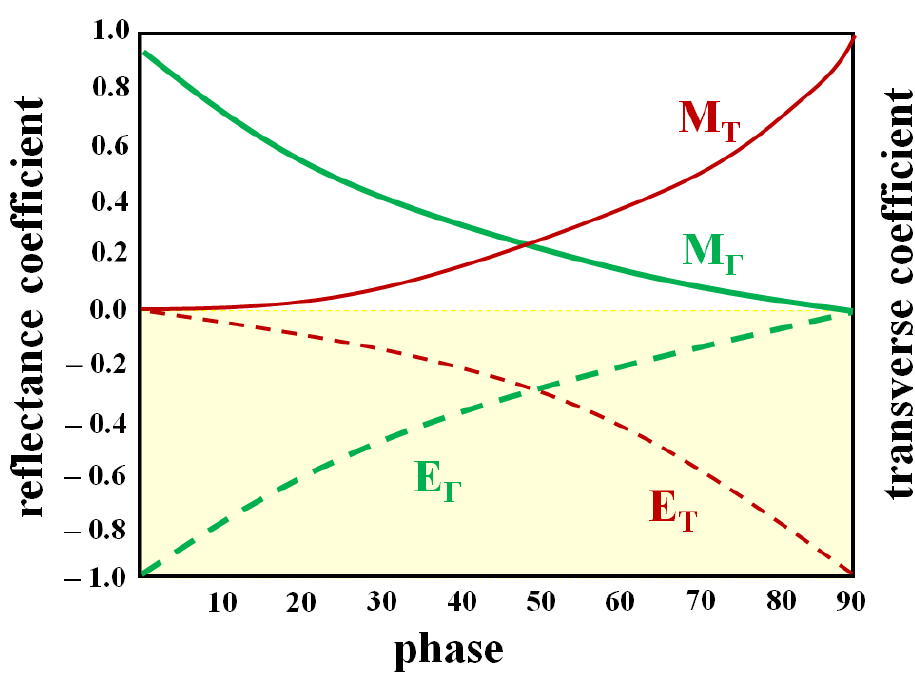
Figure 5. Coefficient of transverse and reflection.